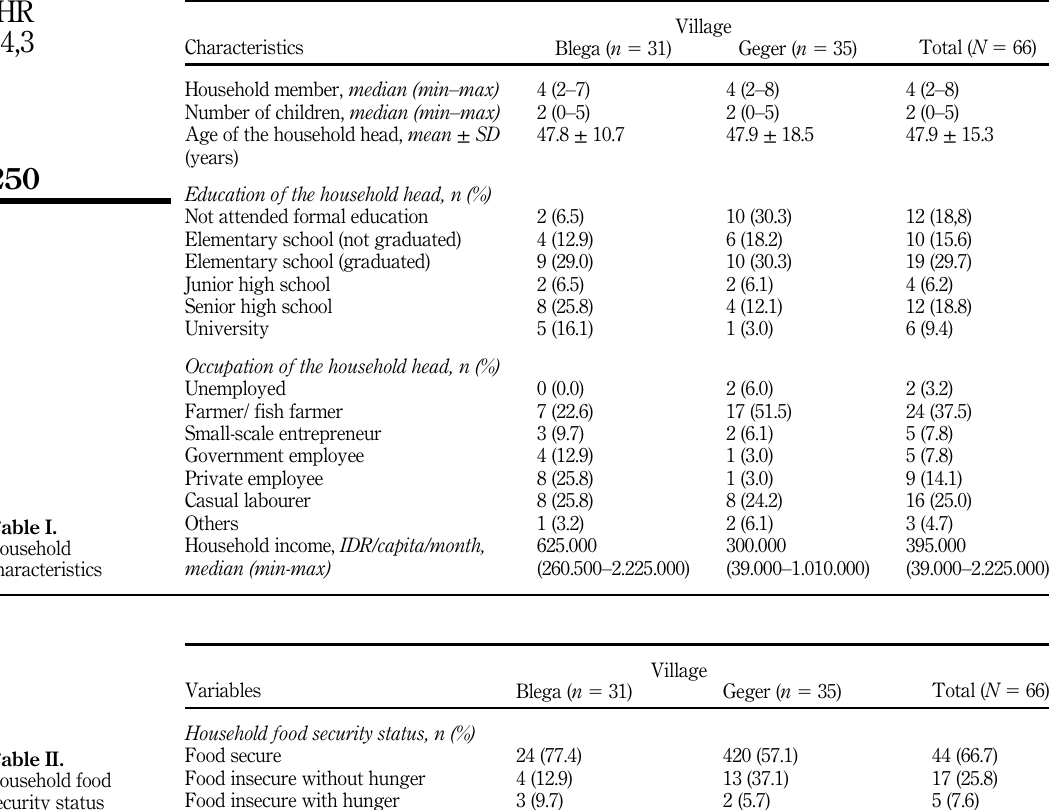
Table II. Household food security